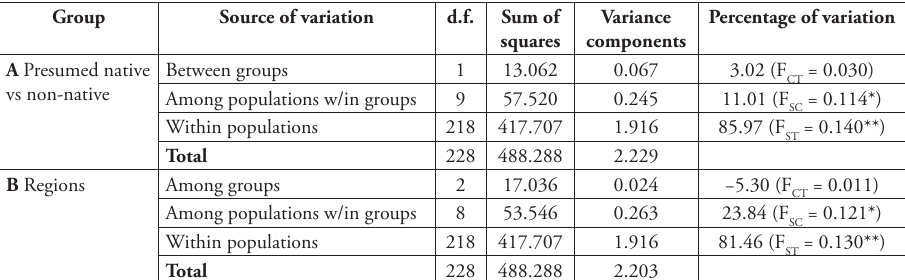
Table 5. AMOVA tests. Results of the AMOVA tests comparing variation in mitochondrial sequences of Paracaprella pusilla grouped at two geographical levels: (A) presumed native vs non-native, and (B) regions. Significance at p < 0.05 (*) and at p < 0.0001 (**). Statistical probabilities derived from 16000